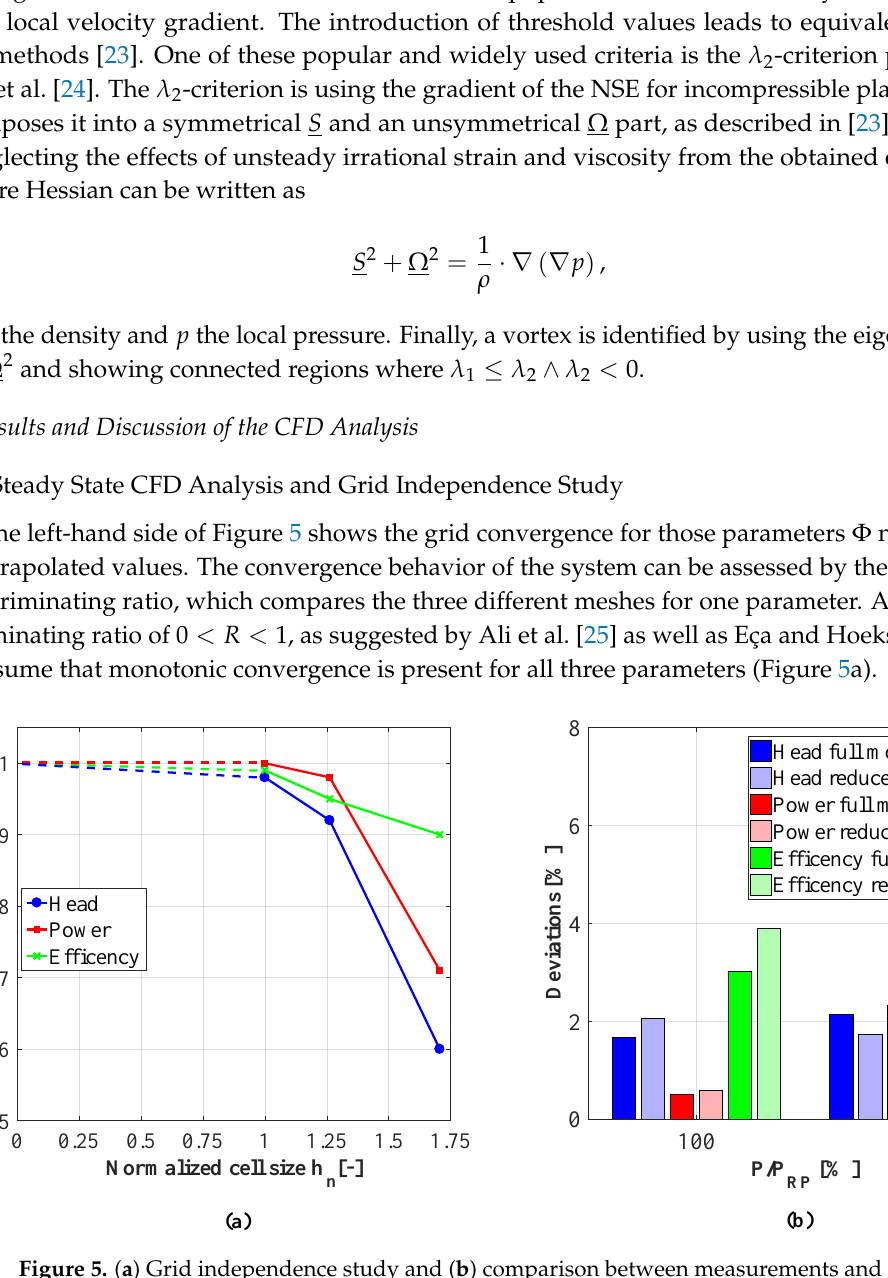
Figure 5. ( a ) Grid independence study and ( b ) comparison between measurements and